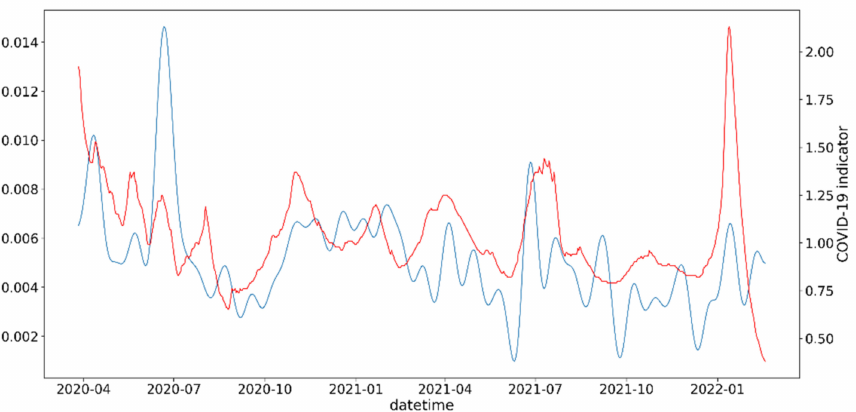
Figure A3. COVID-19 indicator—Reproduction rate. Topic—Test, Week, Talk, Due, Own, Thousand,